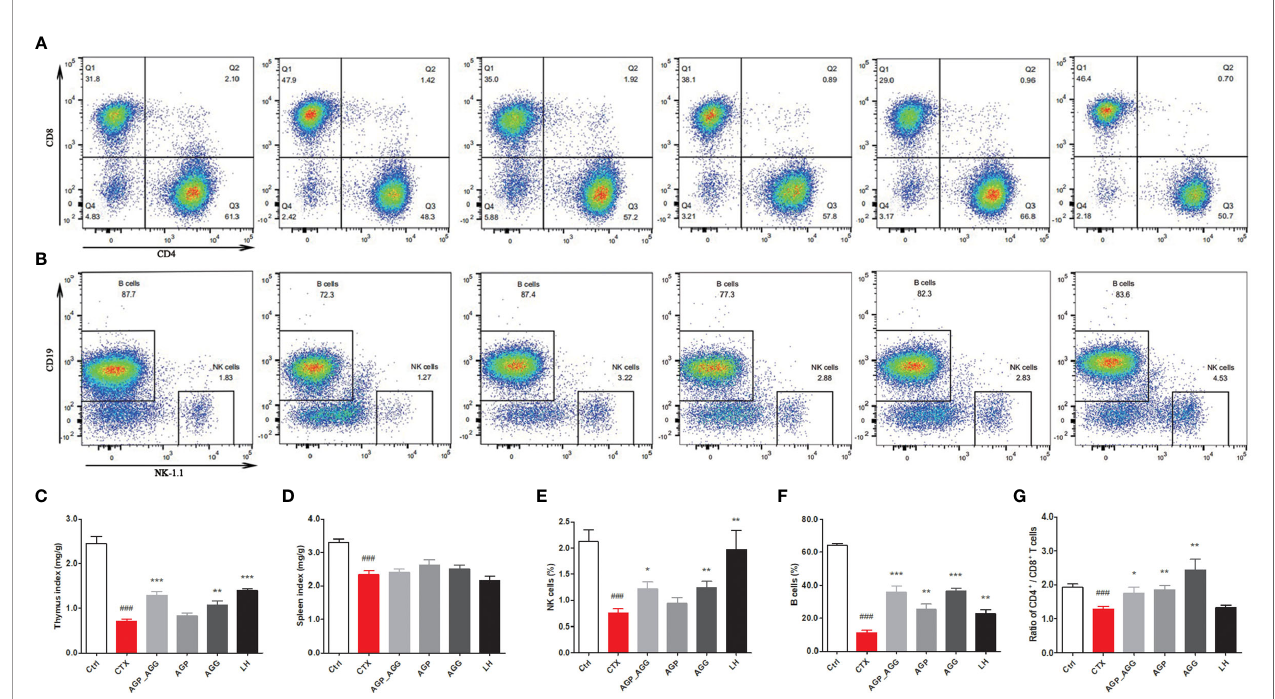
FIGURE 2 | AG treatments altered immune organ indices in CTX-induced immunosuppression mice. (n=7 for each group). (A) The proportion of splenic CD4 + CD8 + T cells was detected by fl ow cytometry. (B) The proportion of splenic NK1.1 + CD19 + cells was detected by fl ow cytometry. (C) Thymus index. (D) Spleen index. (E) The proportion of splenic NK cells. (F) The proportion of splenic B cells. (G) The ratio of splenic CD4 + /CD8 + T cells. Data are expressed as mean with SD. ### P < 0.001 compared with Ctrl; * P < 0.05, ** P < 0.01, *** P < 0.001 compared with CTX by student t test. Ctrl, control group; CTX, cyclophosphamide-induced immunosuppressive group; AGP_AGG, American ginseng polysaccharide+American ginseng ginsenoside with cyclophosphamide-induced immunosuppressive group; AGP, American ginseng polysaccharide with cyclophosphamide-induced immunosuppressive group; AGG, American ginseng ginsenoside with cyclophosphamide-induced immunosuppressive